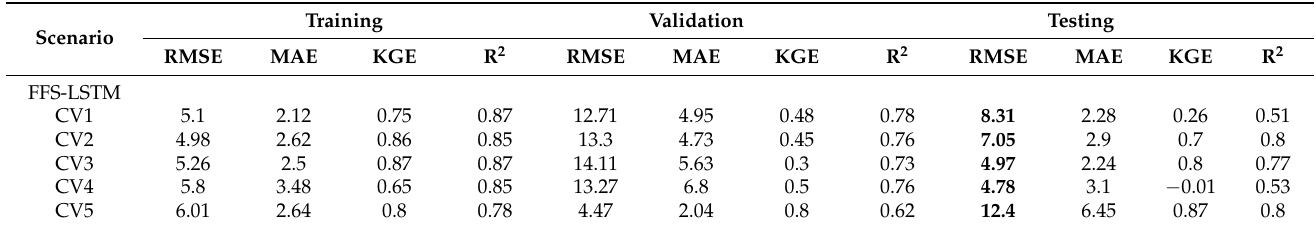
Table 7. Performance of FFS-LSTM scenario for daily streamflow simulation using approach 3 (cross-validation) at TS =